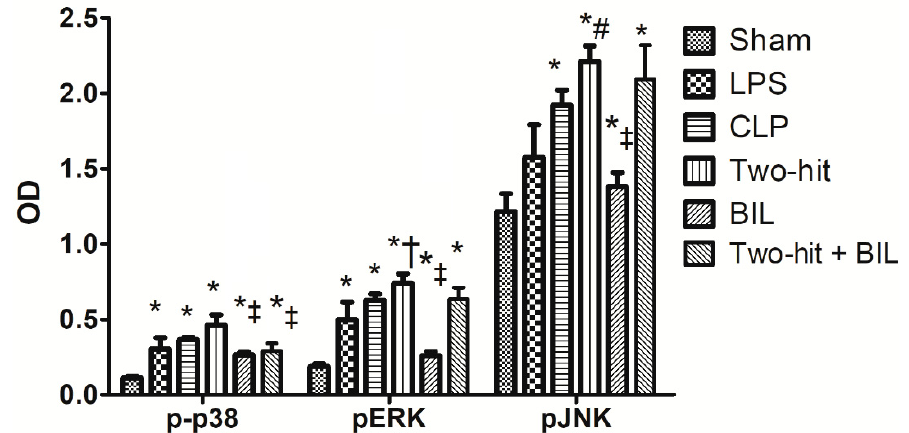
Figure 3. Bilirubin e ff ects on the expression of MAPK kinase in the lung of the “two-hit” sepsis model. Mice were administered i.p. LPS at 5 mg / kg body weight on day 0. After 24 h, the mice were challenged with cecal ligation and puncture (CLP: 25-gauge needle and double-puncture). Next, the mice were administered bilirubin at 30 mg / kg body weight. The levels of MAPK kinase in the lung were determined by ELISA after one day. Data are shown as mean ± SD ( n = 5 mice per group) and analyzed by one-way ANOVA with Tukey-Krammer multiple comparison test using the SPSS program. * p < 0.05 versus sham. # p < 0.05 versus LPS. † p < 0.05 versus CLP. ‡ p < 0.05 versus “two-hit”.